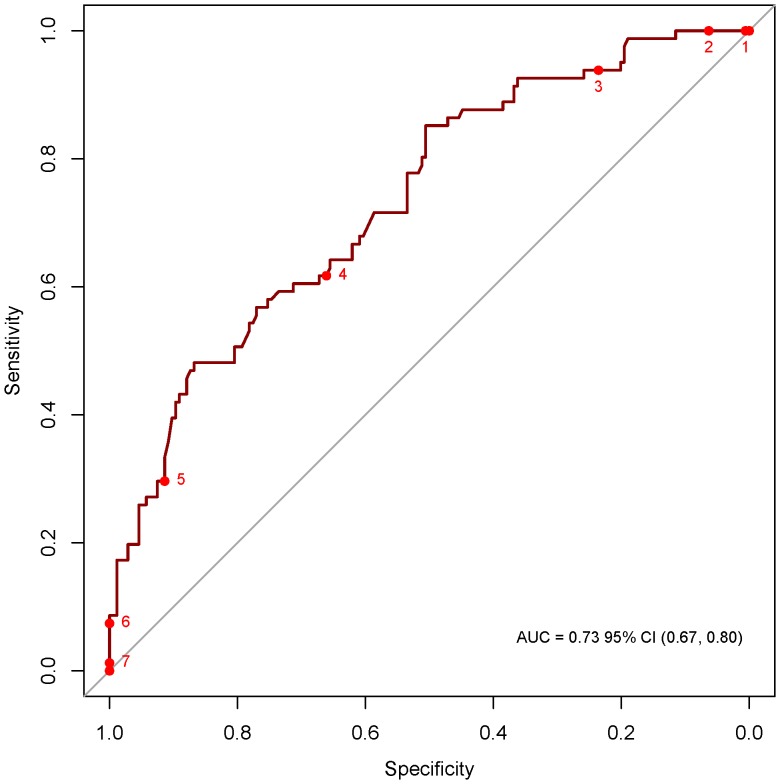
Receiver operating characteristic (ROC) curve indicating specificity and sensitivity of the risk score (Numbers indicate score-cutoffs).